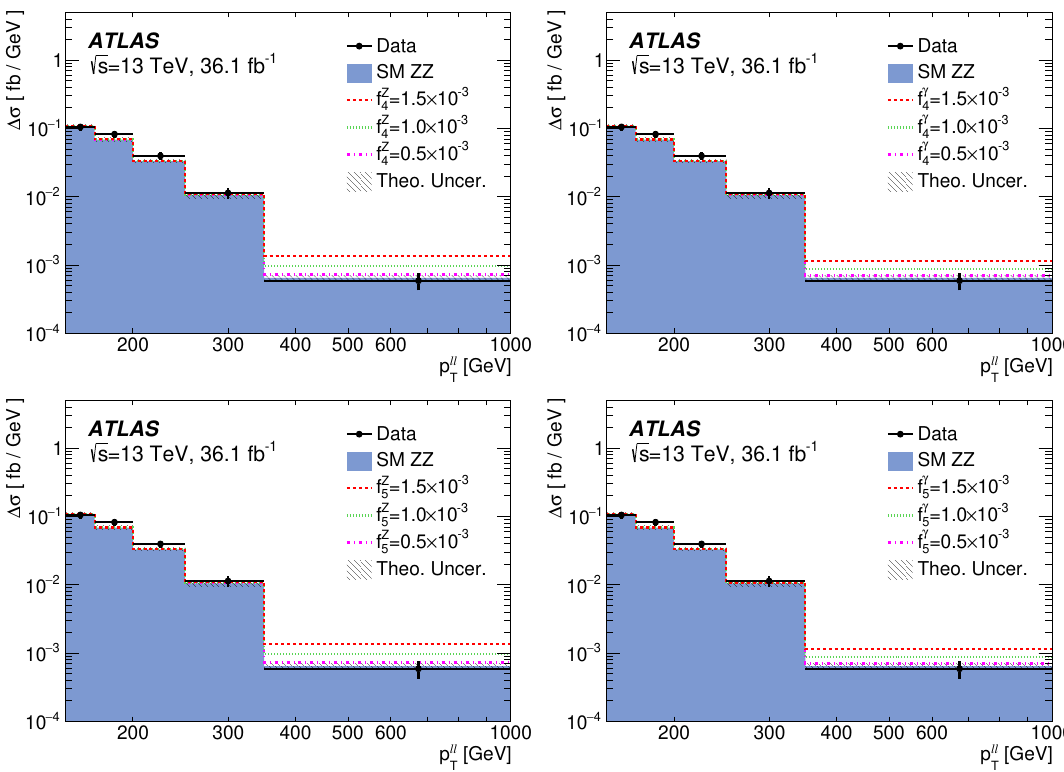
Figure 8 . Unfolded measured distribution of p ‘‘ compared with the SM prediction from Powheg+gg2vv with higher-order K -factors to which are added possible aTGC contributions for di(cid:11)erent values of the strength of the coupling parameters de(cid:12)ned in the text. The results are shown separately for f Z left), and f (cid:13) (bottom right). The uncertainty band represents the theoretical uncertainties in the 5 SM